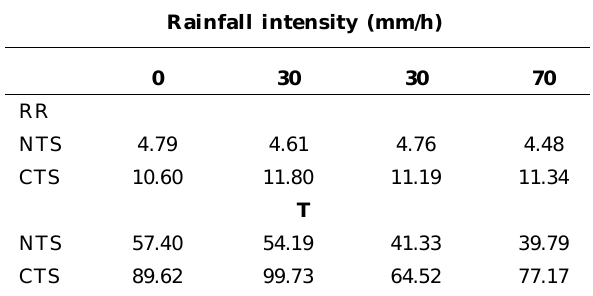
Table 3. Mean values of random roughness (RR) and tortuosity (T) after each simulated rainfall event Rainfall intensity (mm/h)